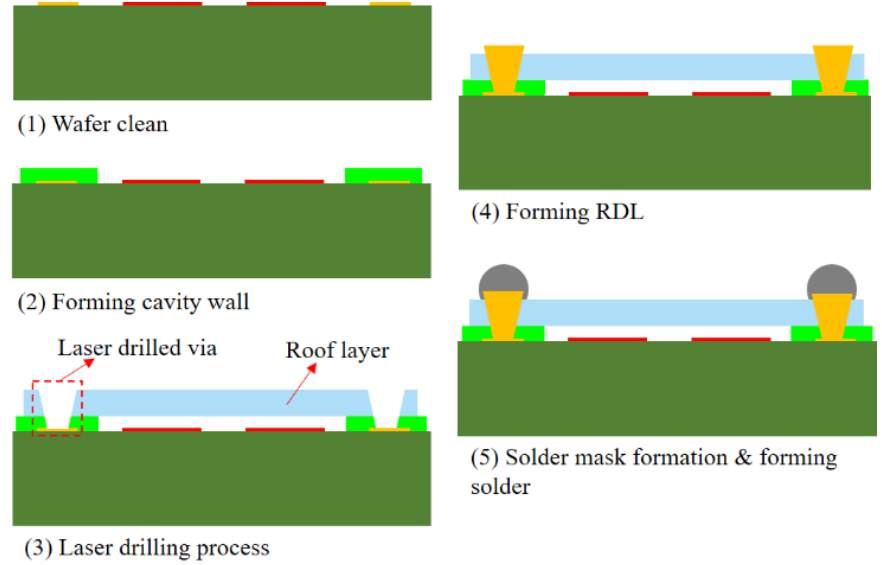
Figure 2. The process flow of the 3D WLP package.